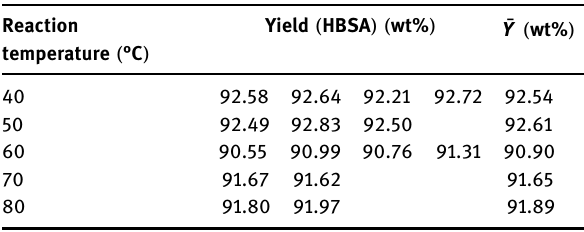
Table 2: HBSA yields at various temperatures